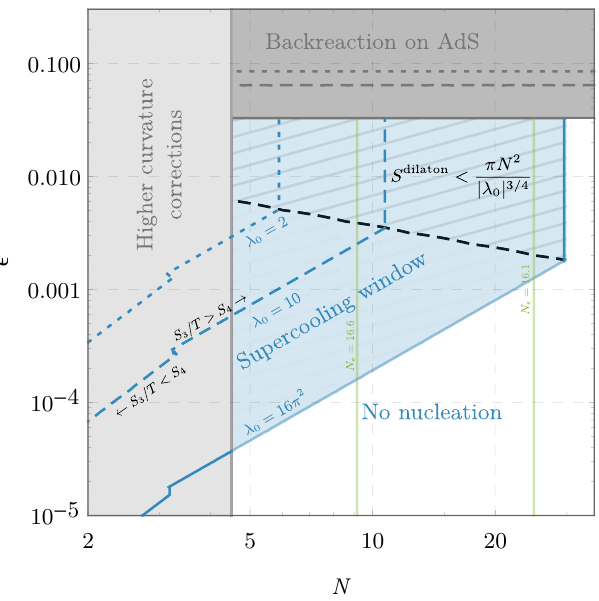
Figure 7 . The supercooling window for a large N strongly coupled CFT with confining scale Λ = 1 TeV . The light blue region marks the supercooling window for the maximal dilaton quartic λ 0 = 16 π 2 . Dashed and dotted lines indicate how the window shrinks for smaller | λ 0 | . In white , the region where nucleation is inefficient and a first order transition fails to complete. In the light gray ( dark gray ) region higher order terms in N (in (cid:15) ) are non-negligible. In the hatched region the incalculable CFT contribution to the bounce action dominates the tunneling. The discontinuities in all the blue curves indicate the transition to thermal tunneling driven by the O(3) action which typically happens at low values of N